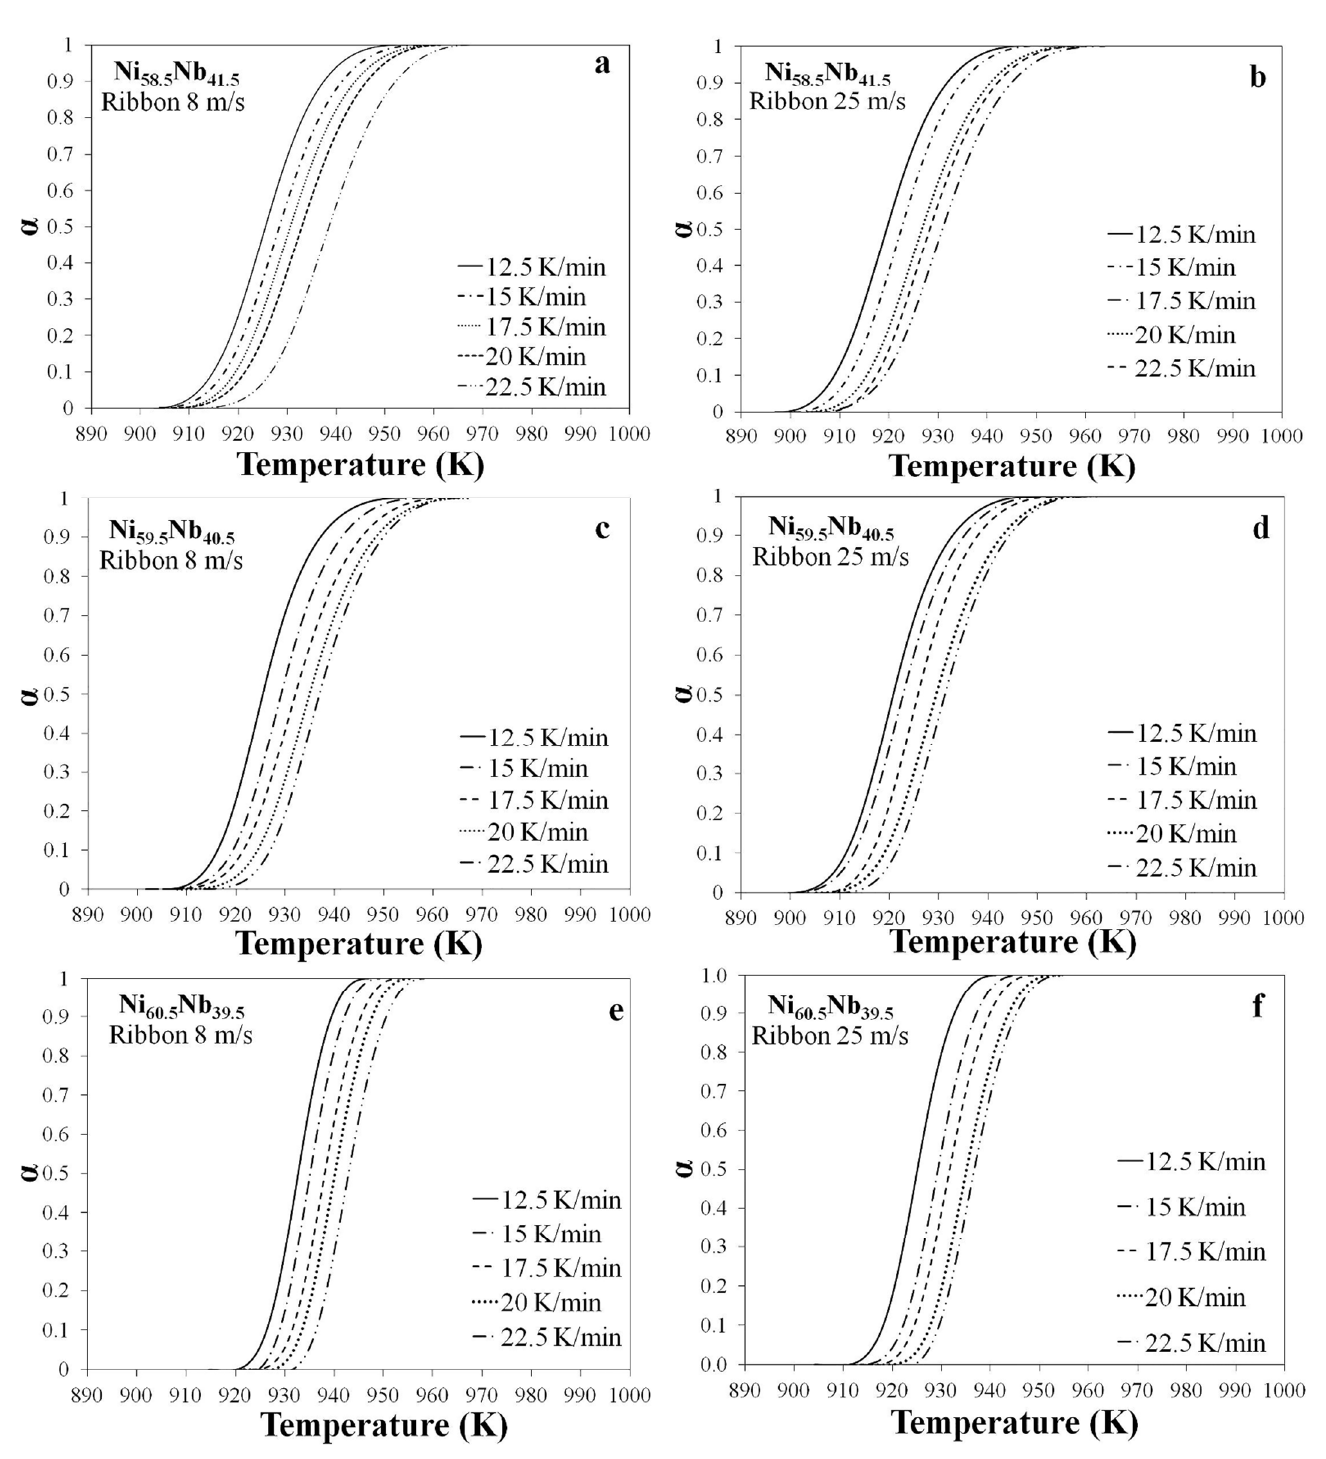
Figure 7. ( a – f ) . Plots α vs. Nb%, from 8 m/s and 25 m/s ribbons of Ni 58.5 Nb 41.5 , Ni 59.5 Nb 40.5 and Ni 60.5 Nb 39.5